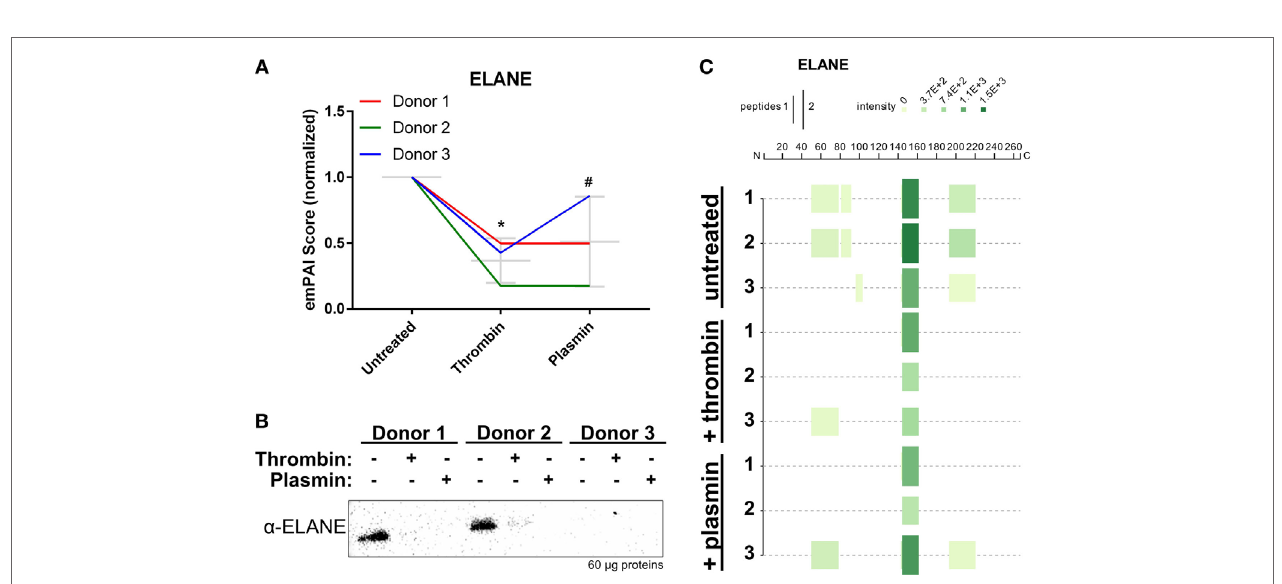
FigUre 6 | Neutrophil extracellular trap-associated neutrophil elastase is changed by thrombin and plasmin. (a) The ELANE’s exponentially modified protein abundance index (emPAI) scores from thrombin- and plasmin-treated samples were normalized against the respective donor’s untreated control. Donor-matched samples are presented ( n = 3). (B) Western blot analysis for ELANE ( α -ELANE, ~27 kDa) with 60 µg of total protein. (c) Peptigram for ELANE was generated using the sum of its respective peptide